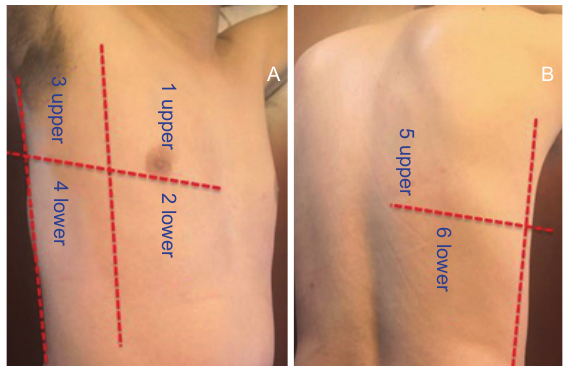
Figure 8 Partitioning methods for unilateral six-zone scheme. (A) supine position; (B) lateral position. Lung regions are divided by anterior and posterior axillary lines into anterior lung, lateral lung, and posterior lung. Three regions were further divided horizontally into 6